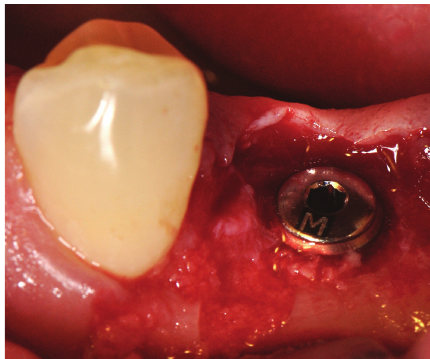
Figure 6: Four-wall bony defect filled with particulate bone